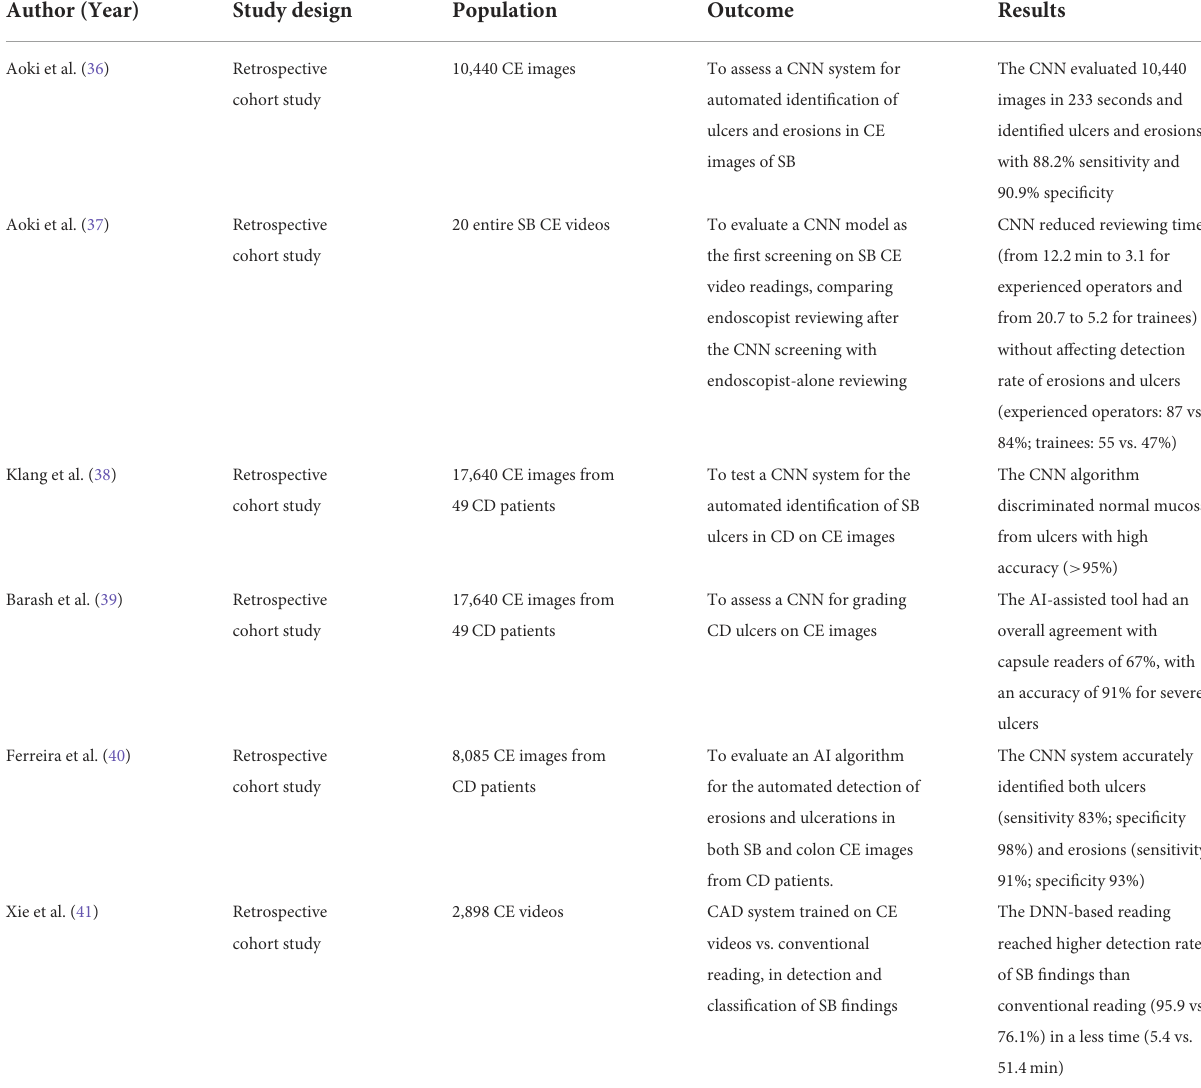
TABLE 2 Key studies on AI application for capsule endoscopy (CE) in